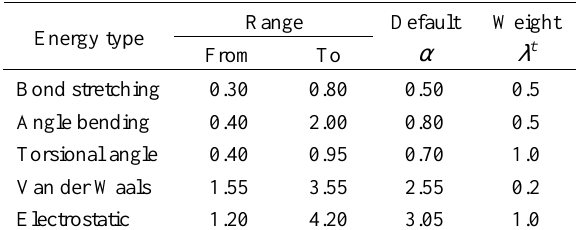
Table 1. Values of spreads and participation weights for different energy